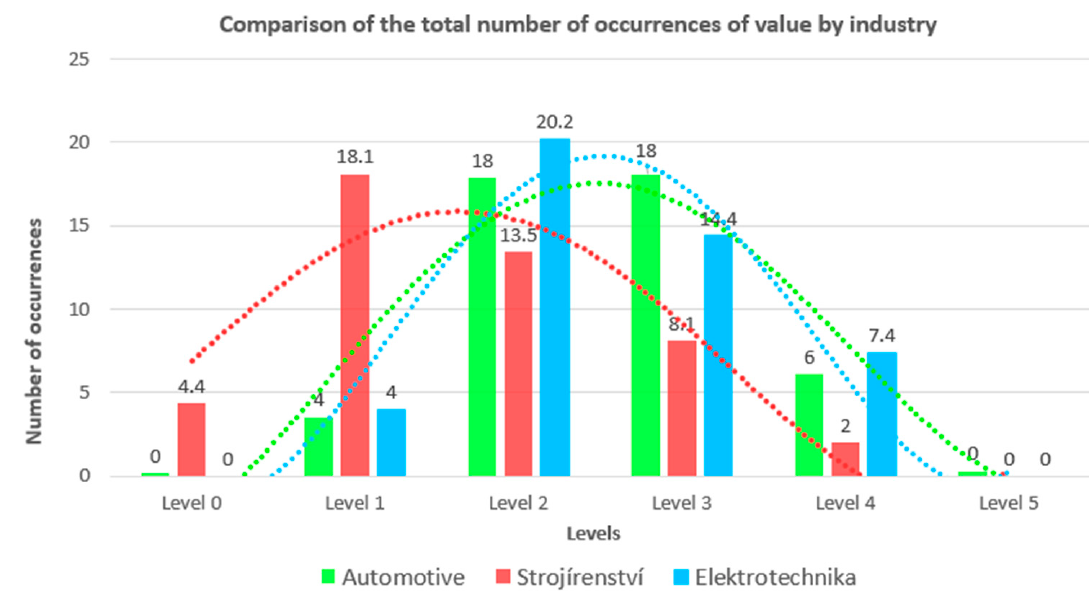
Figure 18. Comparison of the total number of occurrences of values for automotive and mechanical engineering.